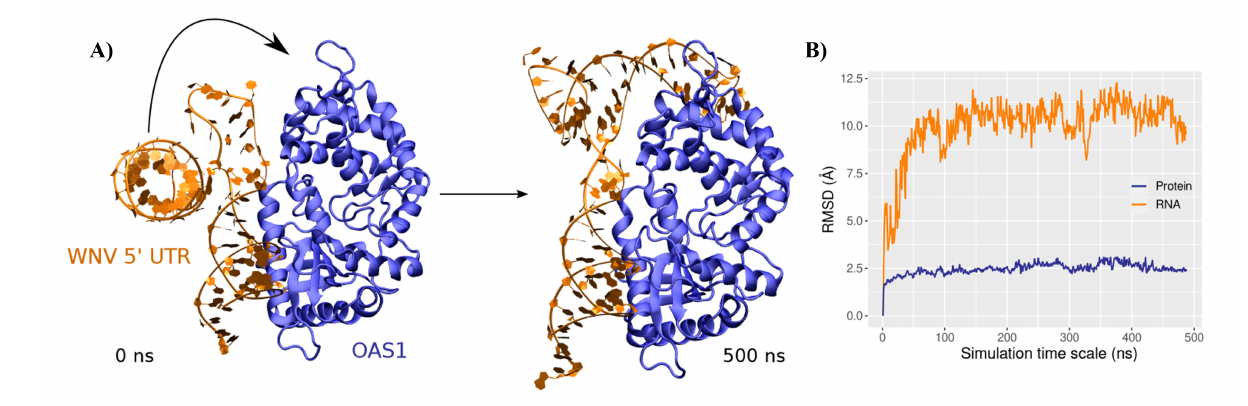
Figure 3. ( A ) Structure of the initial RNA-OAS1 complex generated by docking ( left ) and of the major conformation sampled along the MD run ( right ). The WNV 5 (cid:48) -UTR and the OAS1 protein are depicted in orange and blue, respectively. ( B ) Evolution of the RNA (orange) and protein (blue) root-mean-squared deviation along the MD simulation.